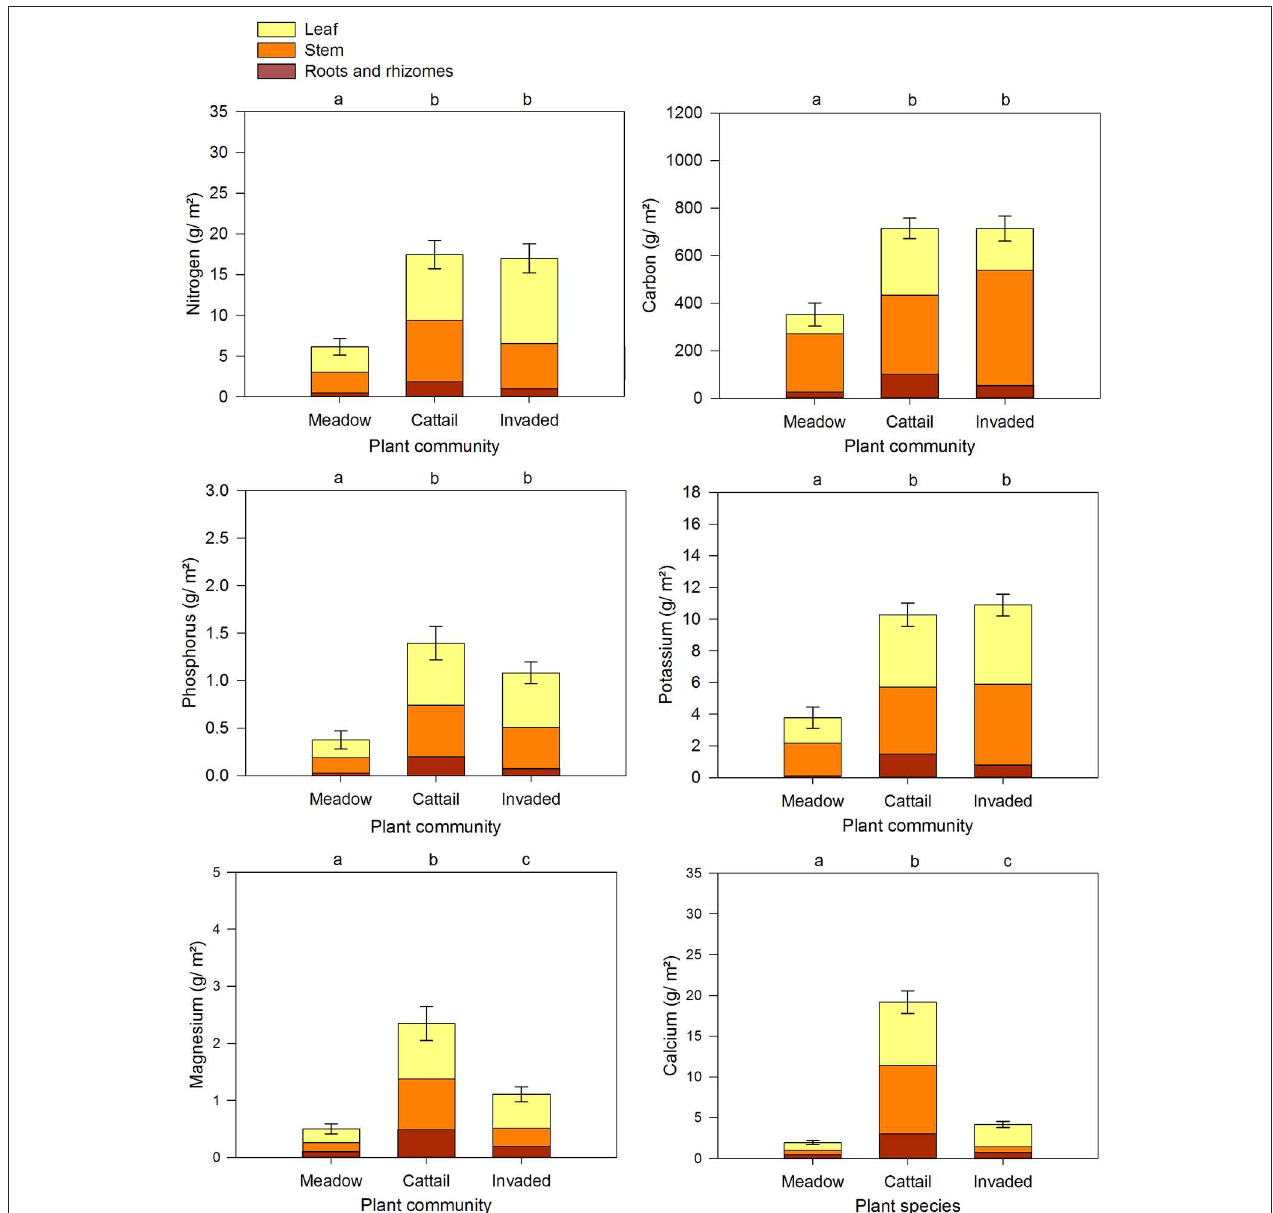
FIGURE 5 | Estimated annual carbon and nutrient standing stocks in the three plant community types broken down by tissue type. The values combine 2016 samples from the Big Creek National Wildlife Area ( n = 5 each from meadow, cattail, and P. australis -invaded marsh) and the Long Point Provincial Park ( n = 5 each from meadow, cattail, and P. australis -invaded marsh) with the 2017 samples from Long Point Provincial Park ( n = 5 meadow, n = 5 cattail, and n = 10 P. australis invaded sites). Error bars reflect standard error in total nutrient standing stock, summed from all tissues. Letters above bars indicate significant differences among plant community types at p < 0.05 ( Supplementary Materials 2